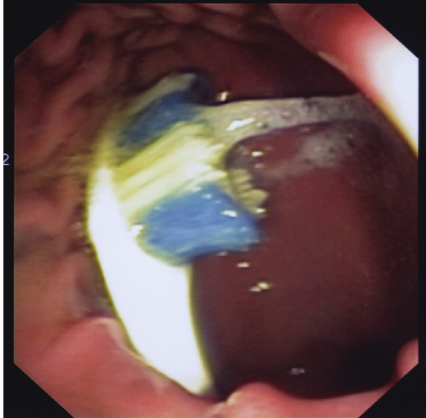
Figure 1: Endoscopic view of toothbrush in gastric antrum, handle having disappeared into the pylorus.